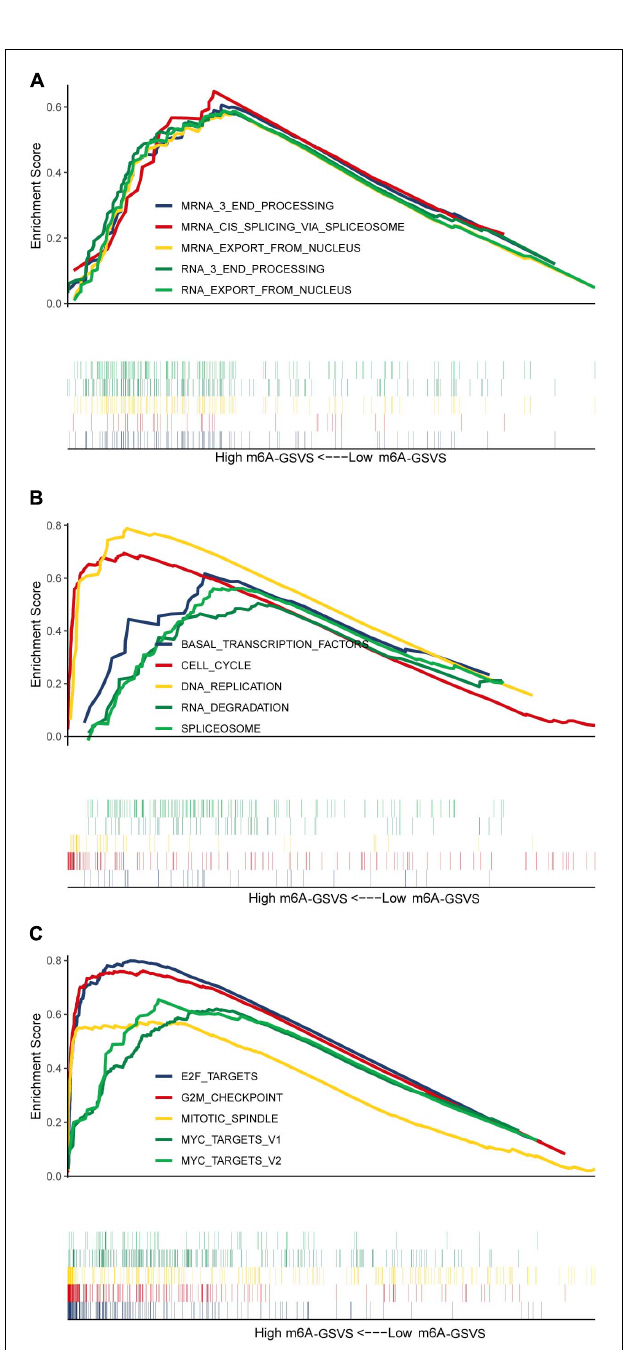
FIGURE 5 | Gene set enrichment analysis. The top five (ranked by false discovery rate) (A) biological processes, (B) KEGG pathways, and (C) hallmark gene sets significantly enriched in samples with high m6A-related gene set variation score (m6A-GSVS).